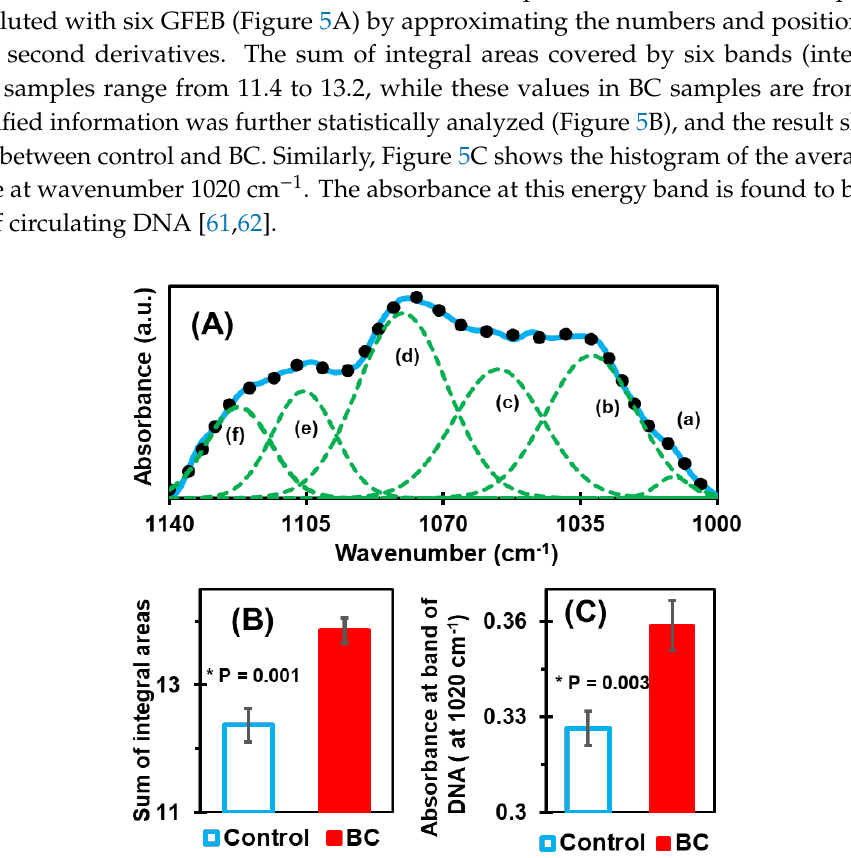
Figure 5. ( A ) Deconvolution of the complex band of carbohydrates and nucleic acids at 1000–1140 cm − 1 . The number and position of the six bands used to fit the experimental curve were determined by using the minima of secondary curves, as in the amide I case. ( B ) Bar graph representation of the average value of the integral sum, which shows a significant di ff erence between the control and BC case. ( C ) Bar graph of the average absorbances at wavenumber position 1020 cm − 1 , which is mainly due to the presence of DNA. It also shows a significant di ff erence between the control and BC cases.